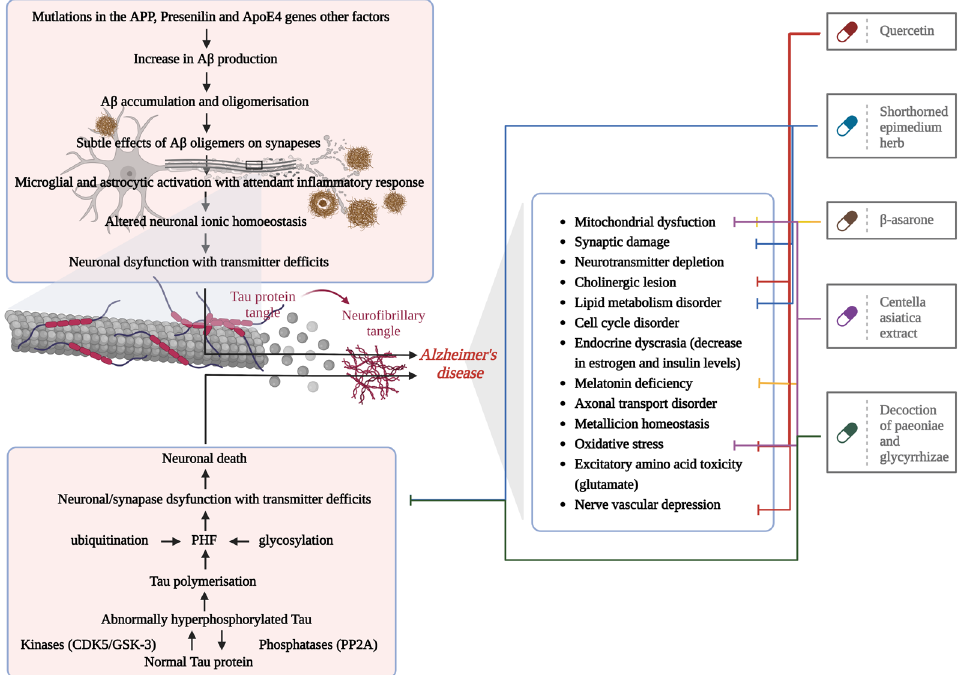
Figure 3. Pathological features of AD and herbal/natural compound strategies. The hallmark patho- logical features of AD are Aβ plaques and tau -containing neurofibrillary tangles. Aβ plaques and tau aggregation can lead to oxidative stress, mitochondrial dysfunction, and the induction of neu- ronal markers of aging. Herbs and natural compounds target the markers of aging to slow the dis- ease process. ApoE4: apolipoprotein E4; APP: amyloid precursor protein; PHF: paired helical fila- ment; CDK5: cyclin-dependent kinases-5; GSK-3: glycogen synthase kinase-3.